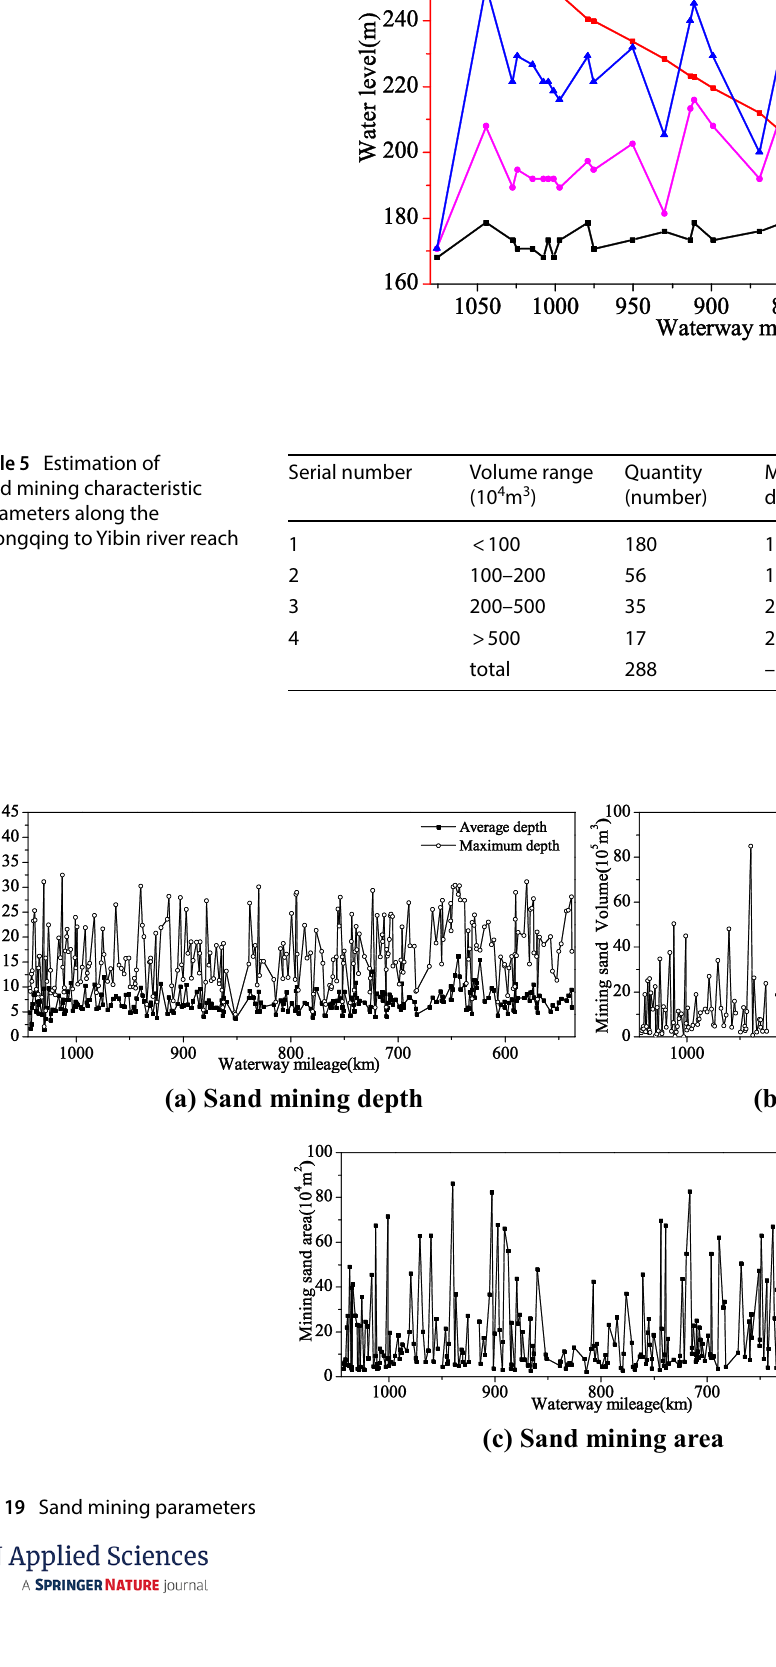
Fig. 18 Water level change under various working condi- tions